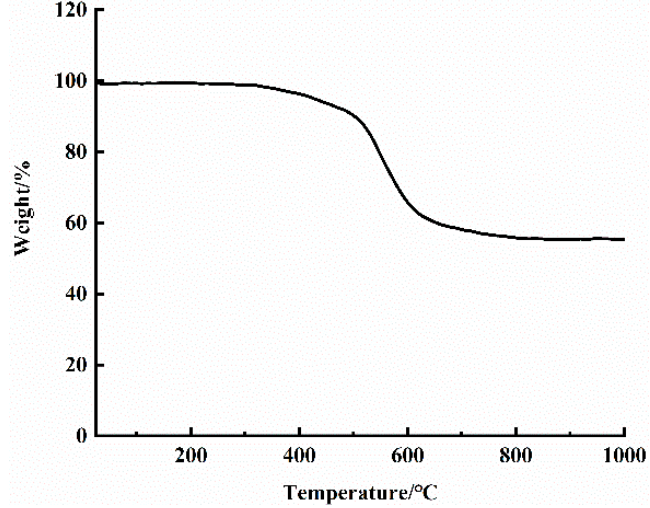
Figure 1. Thermogravimentric analysis (TGA) curve of self-prepared Graphene/PEKK composite powder.